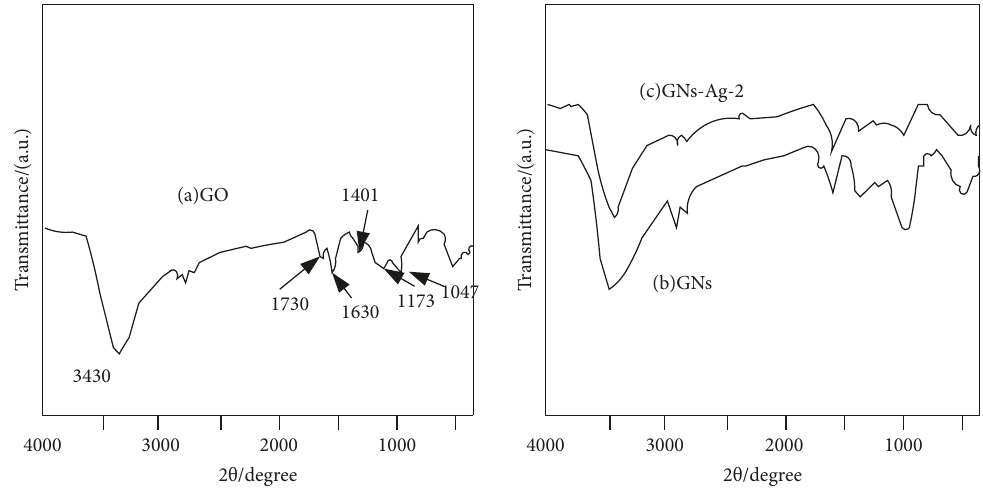
Figure 8: Infrared spectrum of the